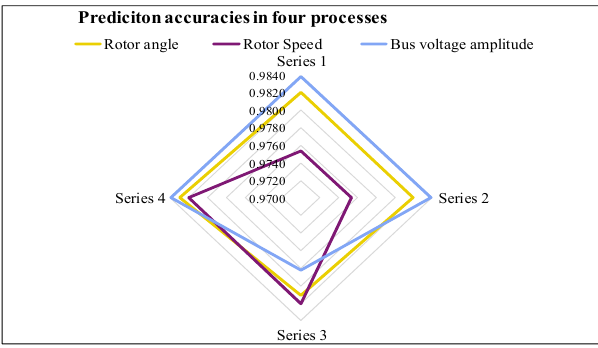
Figure 9. Prediction accuracies of the 4-sample series.